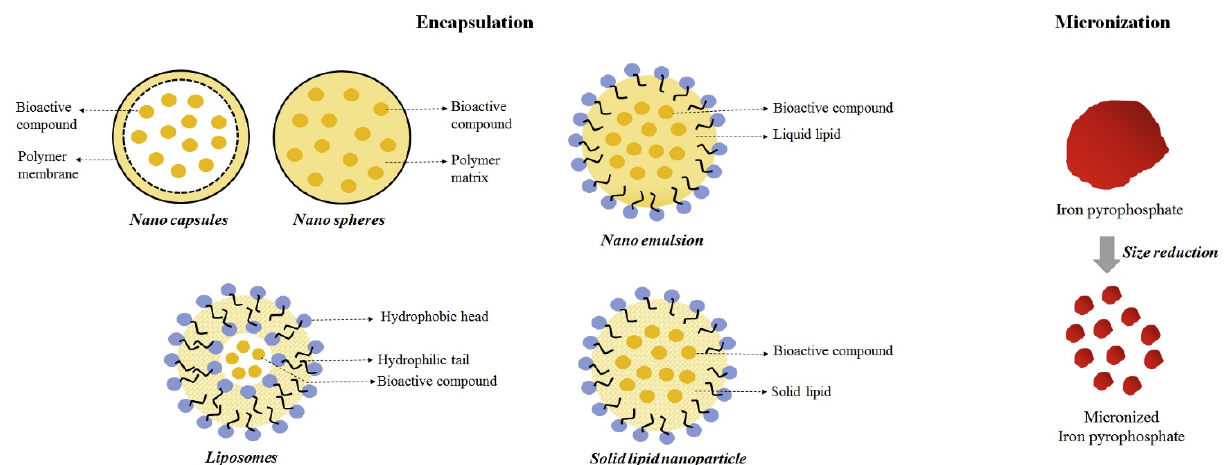
Figure 5. Schematic diagram of encapsulation and micronization approaches for iron